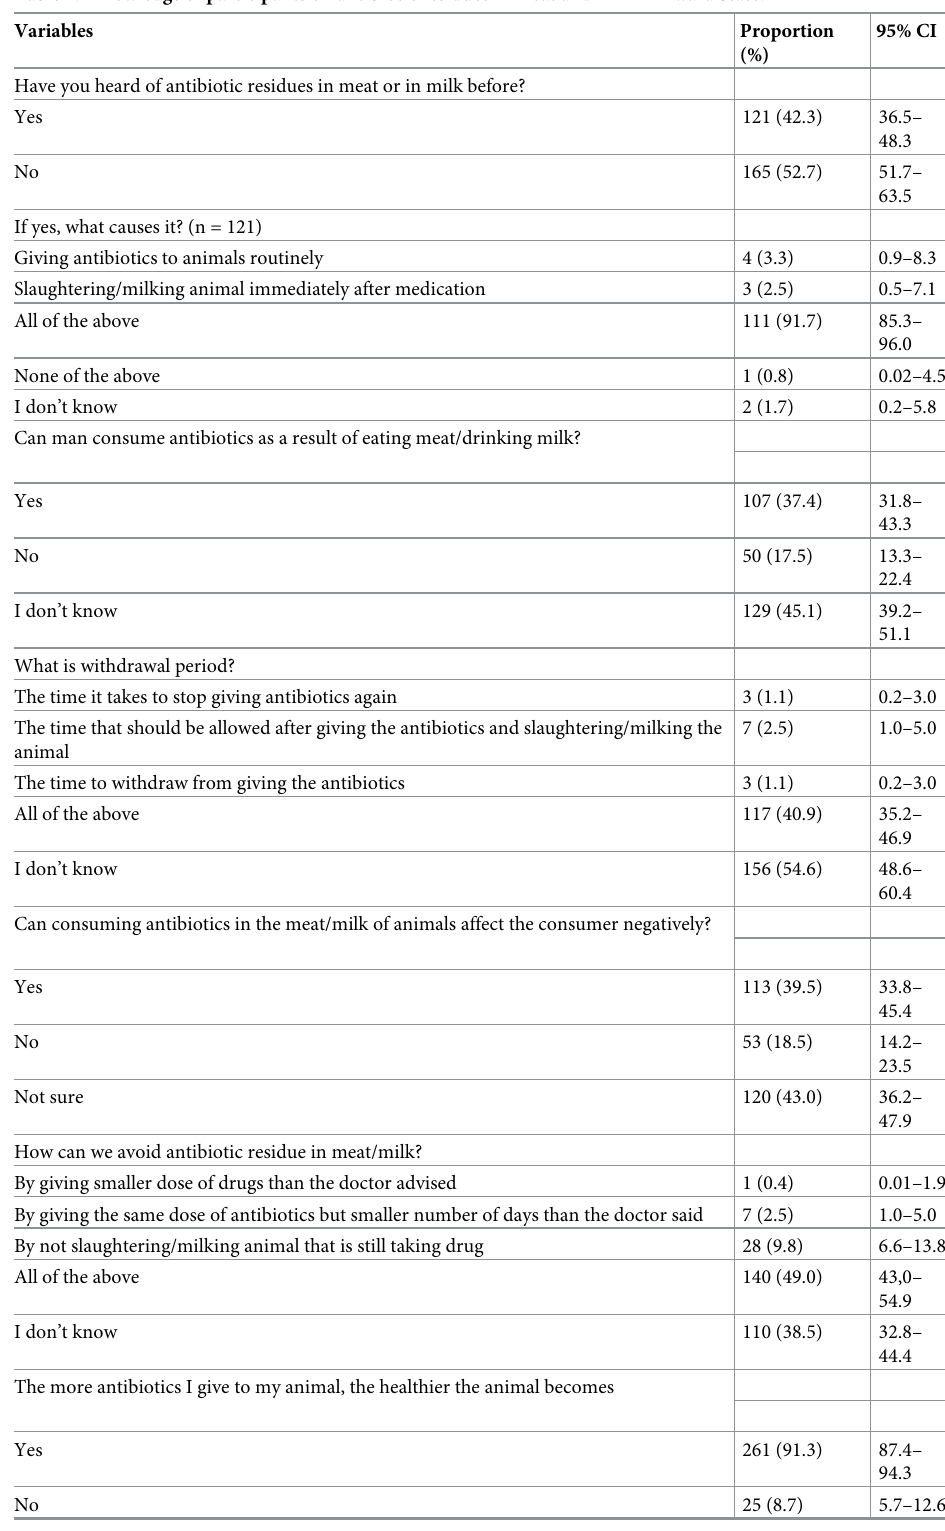
Table 2. Knowledge of participants on antibiotic residues in meat and milk in Kwara